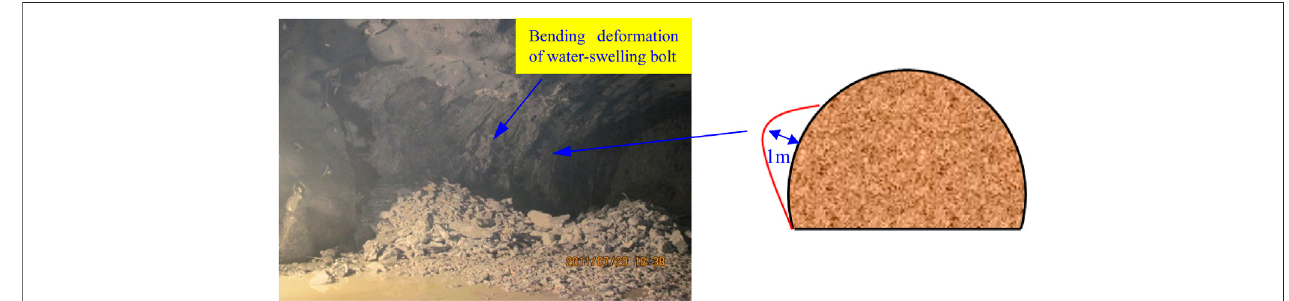
FIGURE 9 | Failure caused by strong rockburst in diversion tunnel #3 on Jul. 20th, 2011.